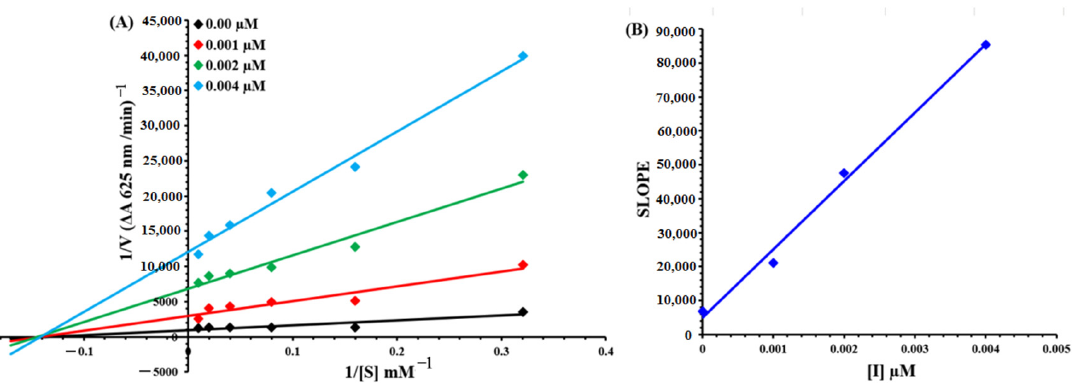
Figure 3. Compound 4i inhibiting urease in a Lineweaver–Burk plot ( A ) Concentrations of 4i were 0.00, 0.001, 0.002 and 0.004 μ M (Blue, green, red and black colored lines). ( B ) The intersect shows the plot of the slope versus inhibitor 4i concentrations to define inhibitory constants. The lines were constructed using least squares linear regression mean ± SEM. Table 2. Urea activity with different concentrations of 4i .